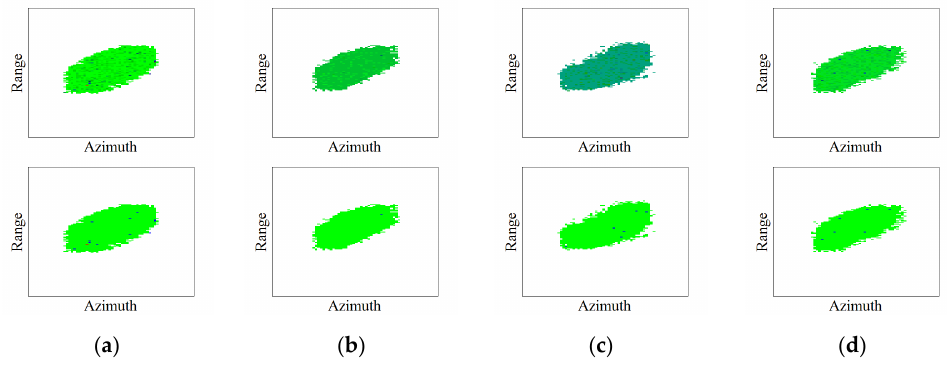
Figure 4. Simulated and real polarimetric radar data of chaff clouds and ships, respectively. ( a – d ) The HH polarization intensity images of chaff clouds for Case 1, Case 2, Case 3-1, and Case 3-2, respectively. ( e ) Pauli color-coded image of Radarsat-2 with marked ships.